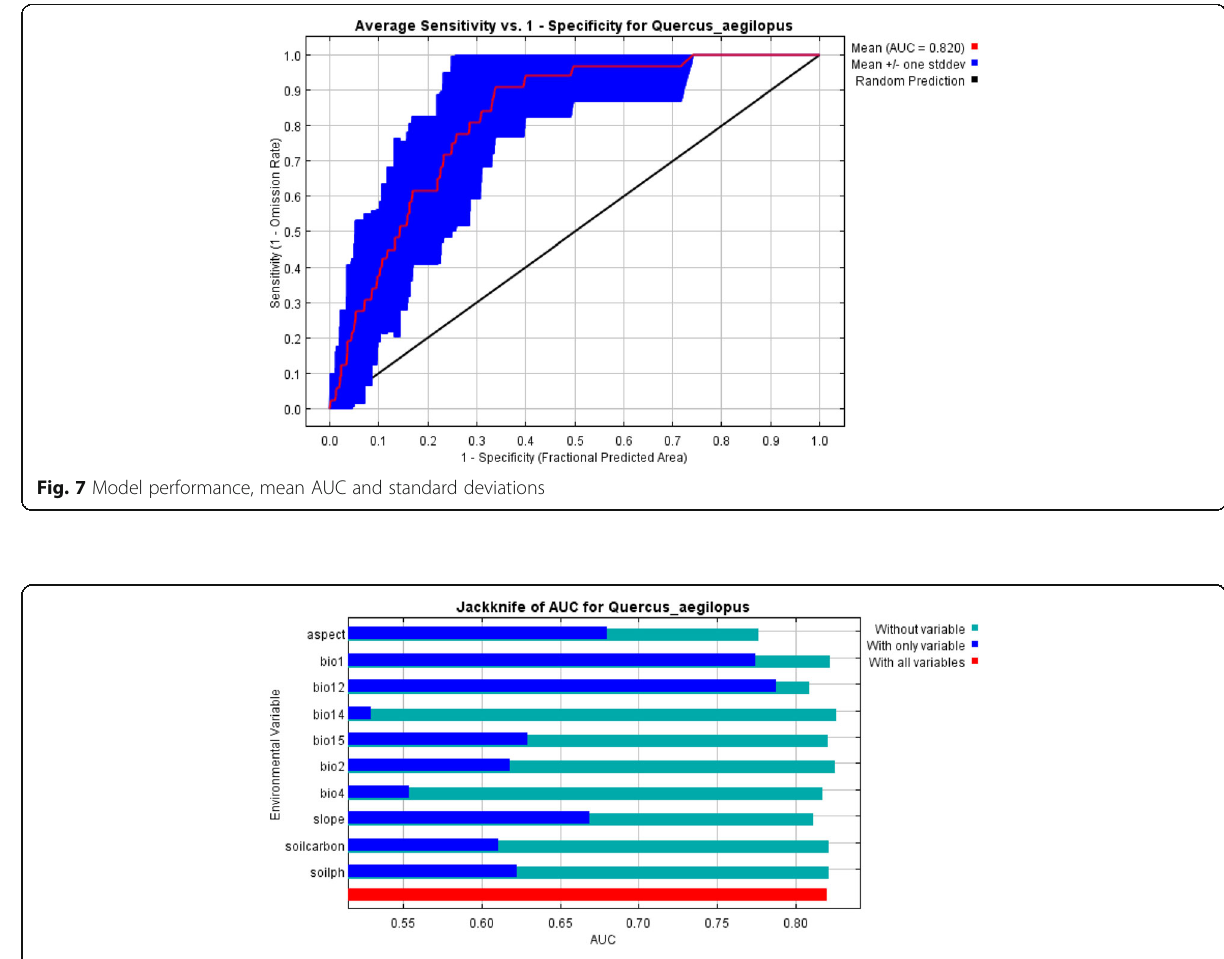
Fig. 8 The Jackknife test for the species for predictor gains (AUC metric)